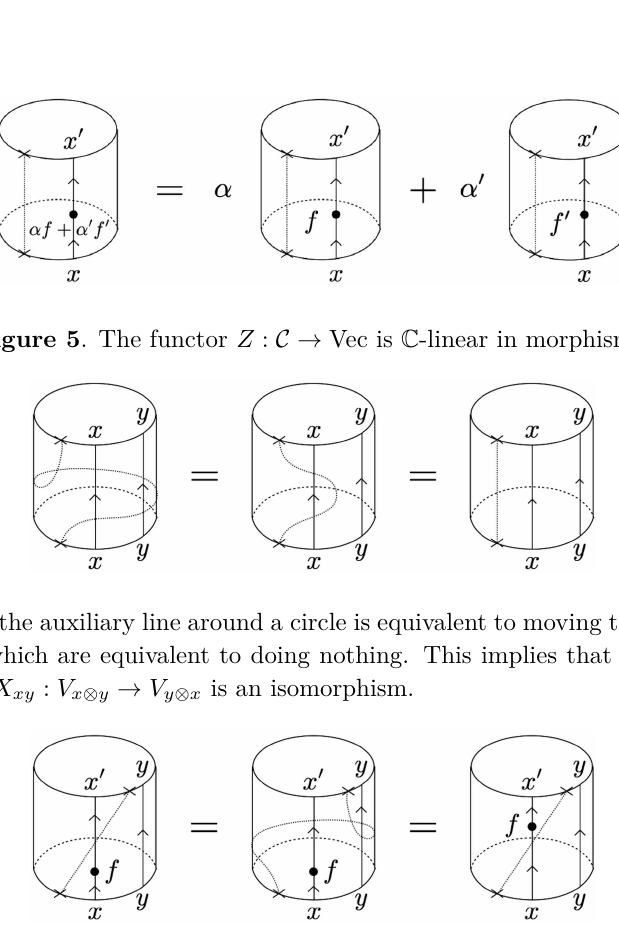
Figure 7 . The change of the base point X xy commutes with a topological point operator on x because we can prevent the auxiliary line from intersecting with the topological defect x by changing the path of the auxiliary line as shown in the middle figure. This means that the auxiliary line is transparent to a topological point operator on x . The auxiliary line is also transparent to a topological point operator on y for the same